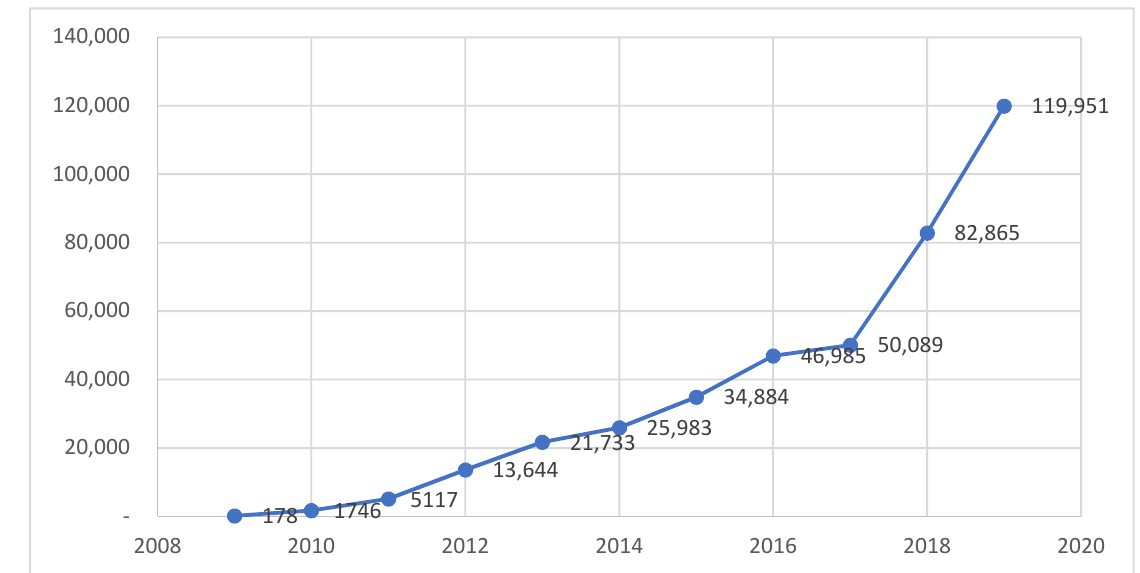
Figure 5. Growth in mobile money transactions per 1000 adults.